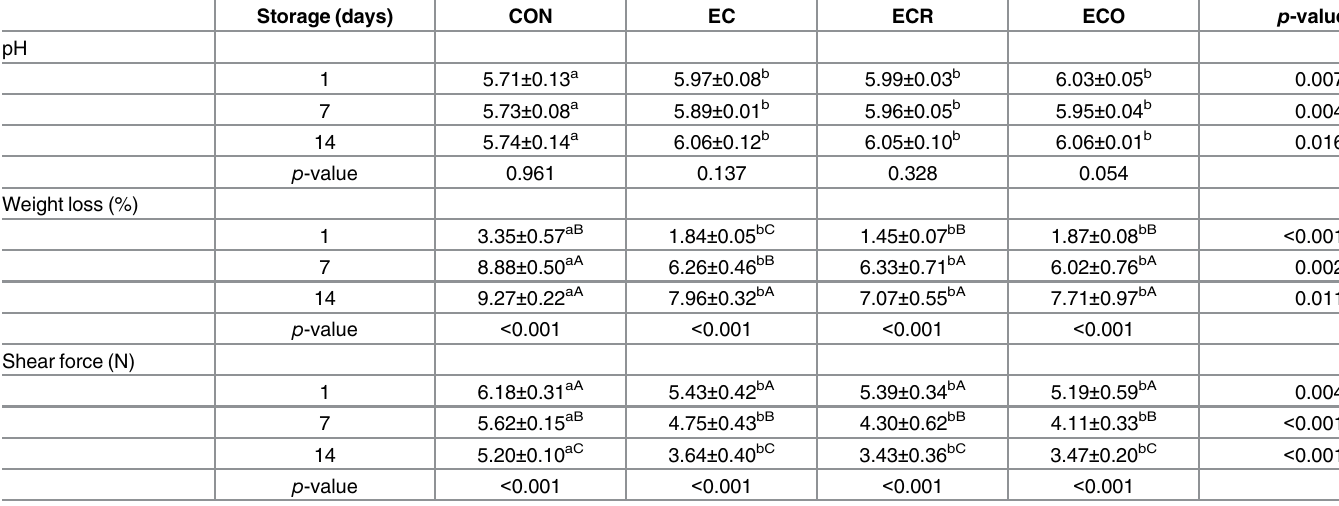
Table 4. pH, weight loss and shear force of meat samples (with and without edible coating) during cold